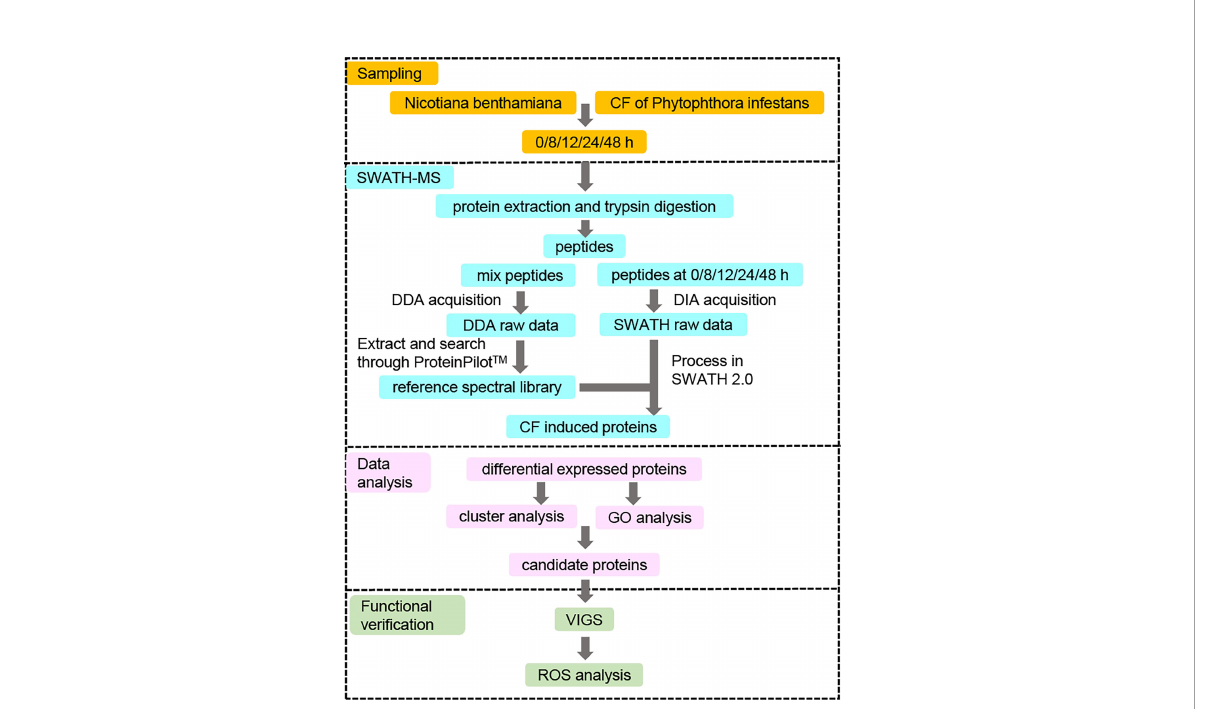
FIGURE 2 Strategy for identifying novel differentially expressed proteins (DEPs) involved in PAMP triggered immunity against Phytophthora infestans . N. benthamiana leaves were in fi ltrated with culture fi ltrate (CF) of P. infestans , and samples were collected at 0 (immediately after in fi ltration), 8, 12, 24 and 48 hpi. Proteins were extracted from the samples at fi ve time points and digested by trypsin for the SWATH-MS analysis. The resulting peptides were fi rst mixed and measured by a data-dependent acquisition (DDA) model to generate a reference spectral library. At the same time, the resulting peptides at each of the fi ve time points were also measured by a data-independent acquisition (DIA) model to obtain SWATH raw data, which were compared to the reference spectral library to get the CF-induced proteins. Differentially expressed proteins (DEPs) were identi fi ed by comparing the expression of CF- induced proteins at 8, 12, 24 and 48 hpi to that at 0 hpi at a fold change of 1.5 with a p -value <0.05. Then protein expression clustering and GO enrichment analysis were performed to get the candidate proteins for the functional veri fi cation by virus-induced gene silencing (VIGS) and reactive oxygen species (ROS)